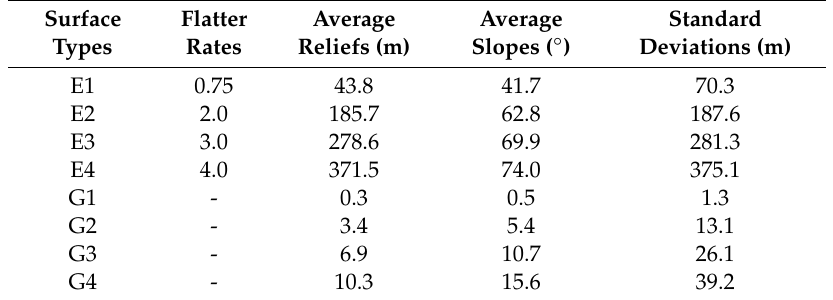
Table 3. Complexity parameters of the eight mathematical surfaces (DEM resolution = 5 m).